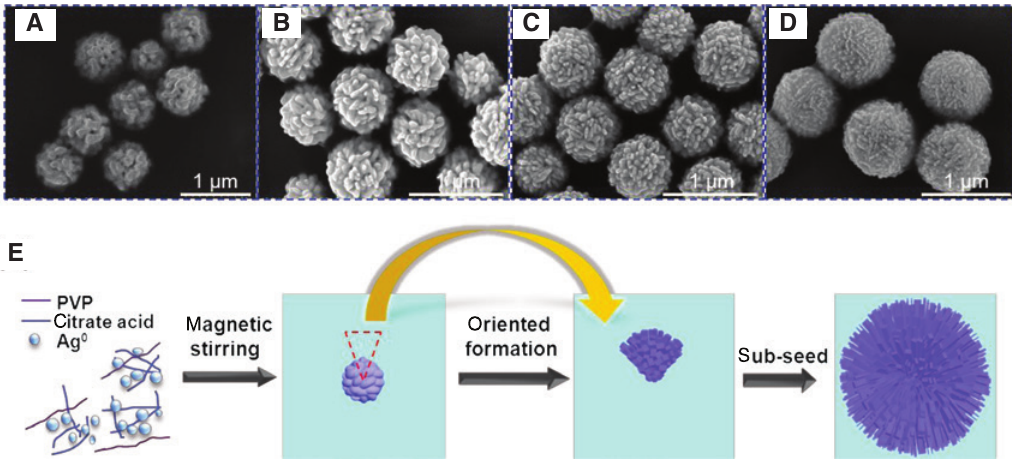
Figure 2: Schematic illustration of the proposed mechanism for the formation of Ag NFs. (A–D) SEM images of Ag NFs grown at the reaction times of 1 s (A), 2 s (B), 3 s (C), and 5 s (D) when the concentration of AgNO ascorbic acid in reaction solution are 38, 38, 1.9, and 38 mm, respectively. (E) Schematic illustration of the proposed mechanism for the formation of Ag NFs in four main